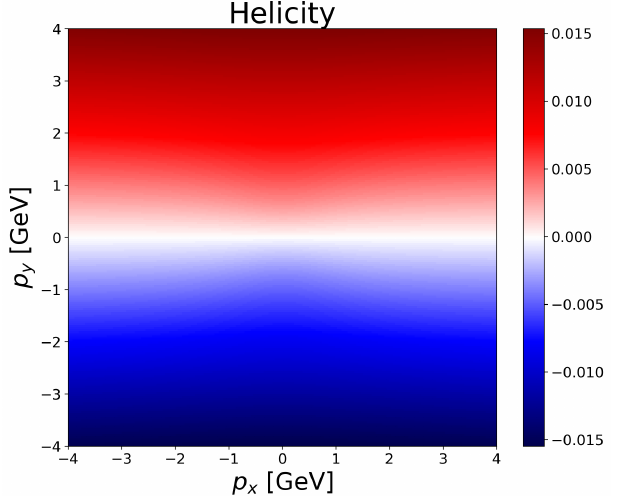
Figure 3. Helicity of the produced baryons calculated in the rotating and accelerating expanding solution. Parameter values as above: m Λ = 1115 MeV/ c 2 , | Ω | = 0.1 c